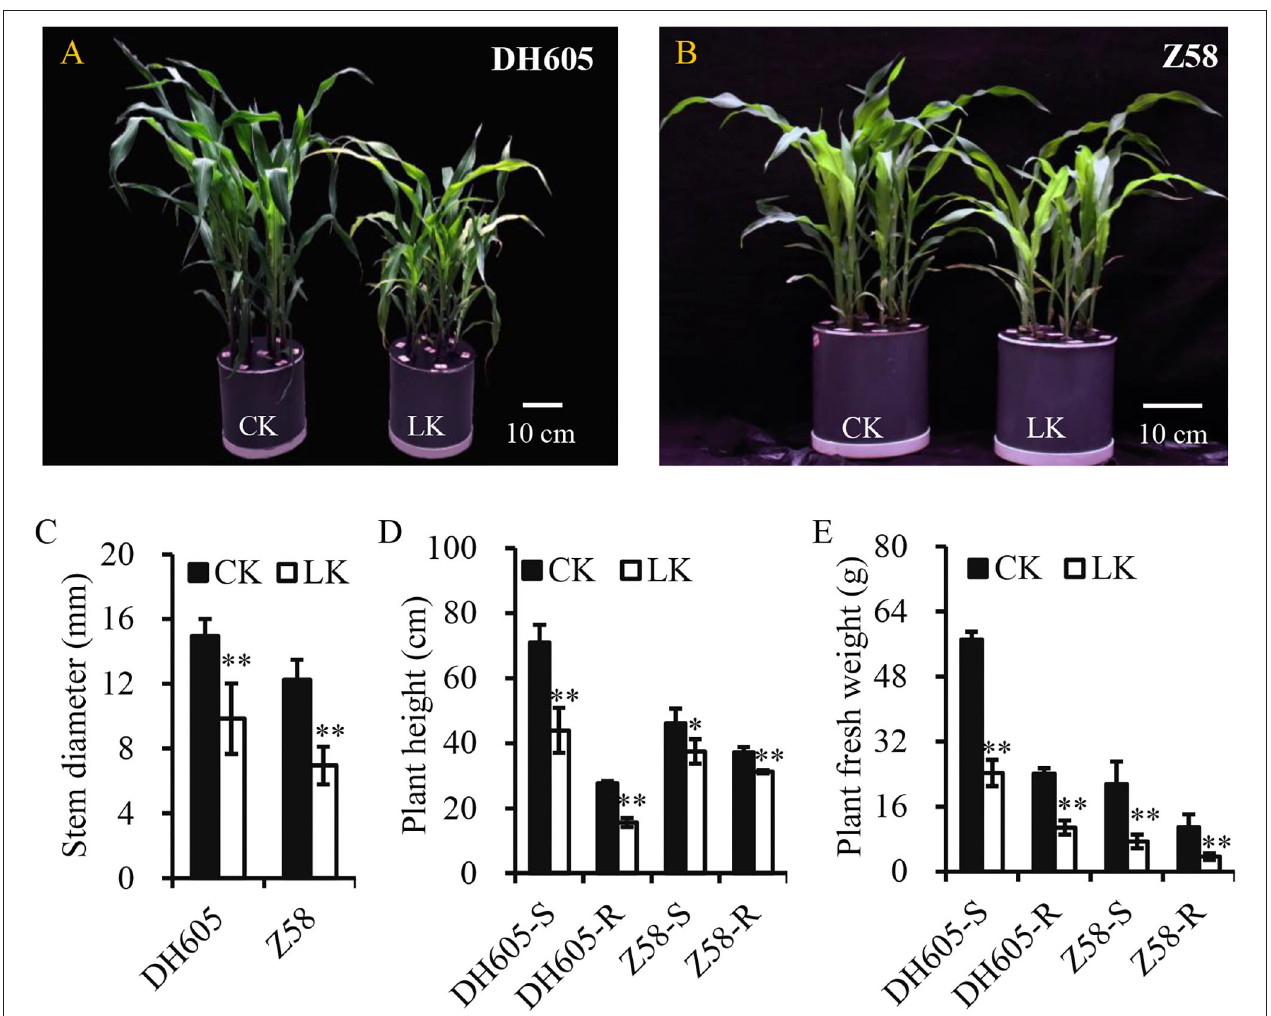
FIGURE 1 | Effect of K + deficiency on maize growth. (A,B) Showed phenotypes of maize DH605 and Z58 under K + treatment for 12 days, respectively. (C–E) showed the variations of average stem diameter, plant height, and plant fresh weight under K + deficiency condition for 12 days, respectively. Two maize varieties, DH605 and Z58, were analyzed to K + deficiency, respectively. CK and LK represent K + sufficiency (4mM) and K + deficiency (0.1mM). Scale bars in (A,B) represent 10cm. The experiments were repeated three times. * and ** on histograms mean the significant difference at the p ≤ 0.05 and p ≤ 0.01 level, respectively. Bars mean SD.